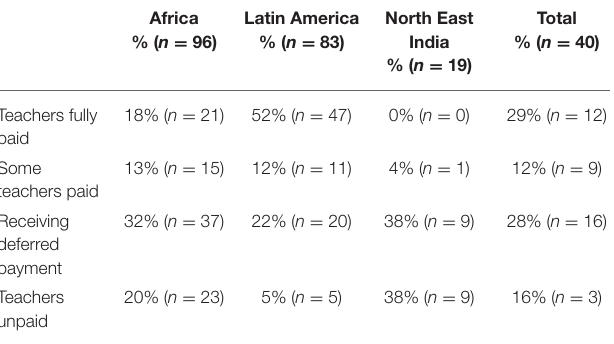
TABLE 5 | Teacher payment status by geographic